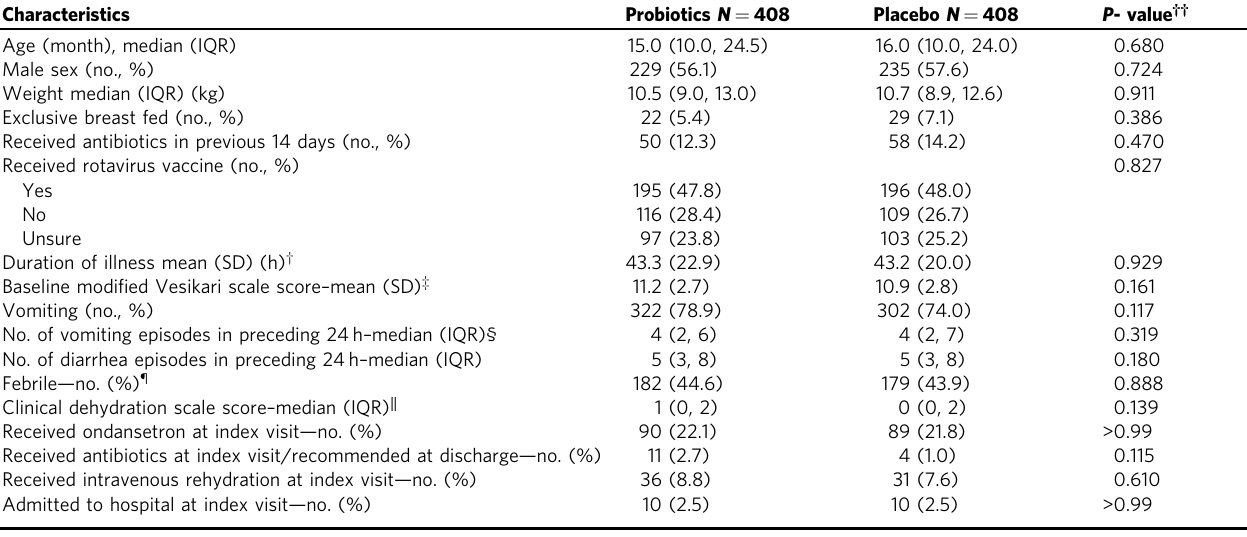
Table 1 Clinical characteristics by treatment groups. Characteristics